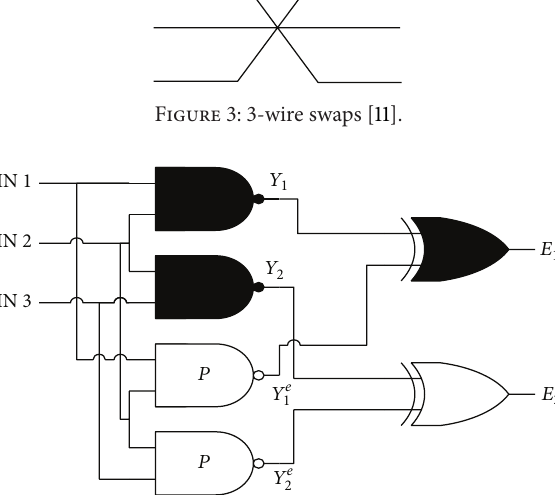
Figure 3: 3-wire swaps [11].